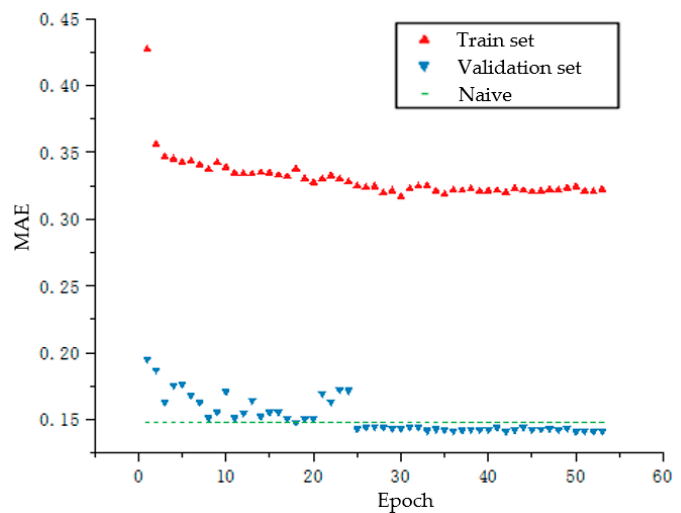
Figure 12. MAE indicator of the RNN-based wind speed prediction model.